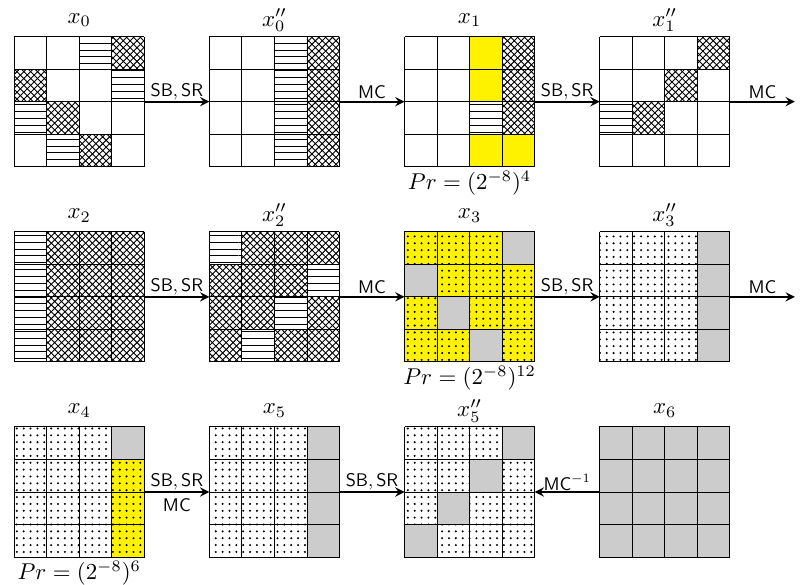
Figure 3. A 6-round AES mixture differential trail with probability 2 − 176